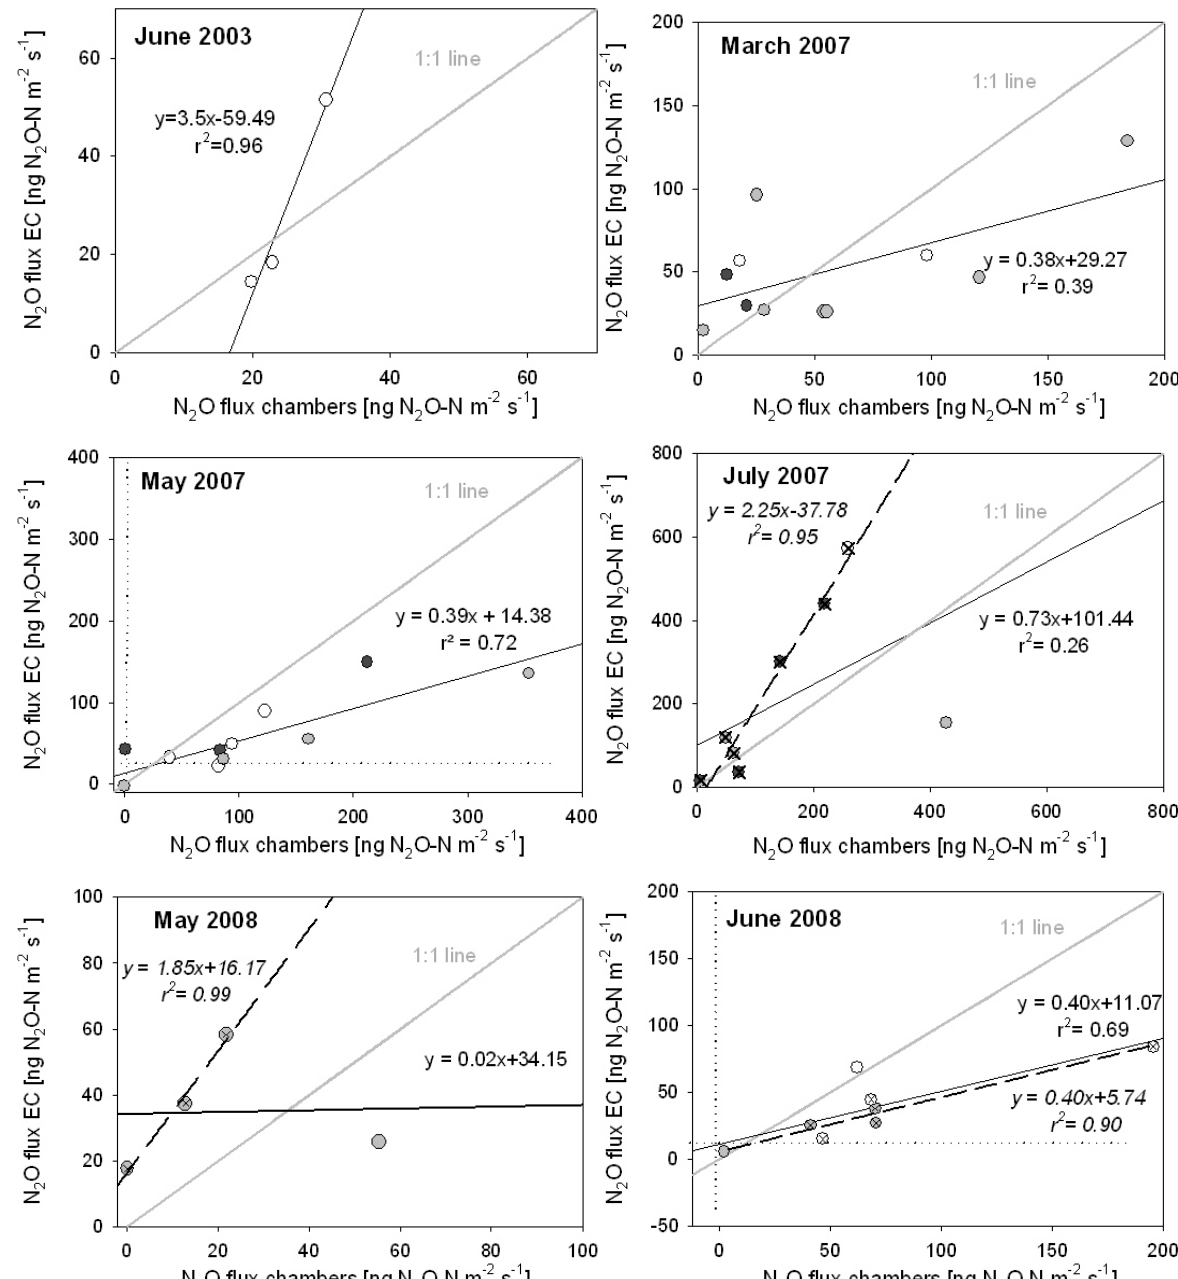
Fig. 3. Comparison of N 2 O fluxes measured at the same times (between 10:00 and 12:00) with eddy covariance (EC) and static chambers for each of the 6 comparison periods and data from all comparison periods. Chamber values represent an average of 14 (2003) or 4 (2007/2008) chambers. Circles represent all comparison points, while crosses represent the retained dataset where outliers were removed. Trend lines represent orthogonal regression (continuous line for all comparison points with non italic model equation, dashed line where outliers were removed with italic model equation). Different shades of circles indicate the contribution of the area in which the chambers were situated to the footprint of the EC measurement (open circles=0–25%, medium grey=26–50%, dark